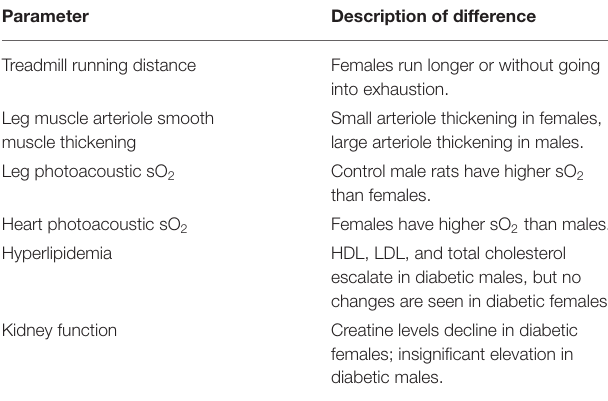
TABLE 3 | Key parameters exhibiting sex-dependent differences. Parameter Description of difference Treadmill running